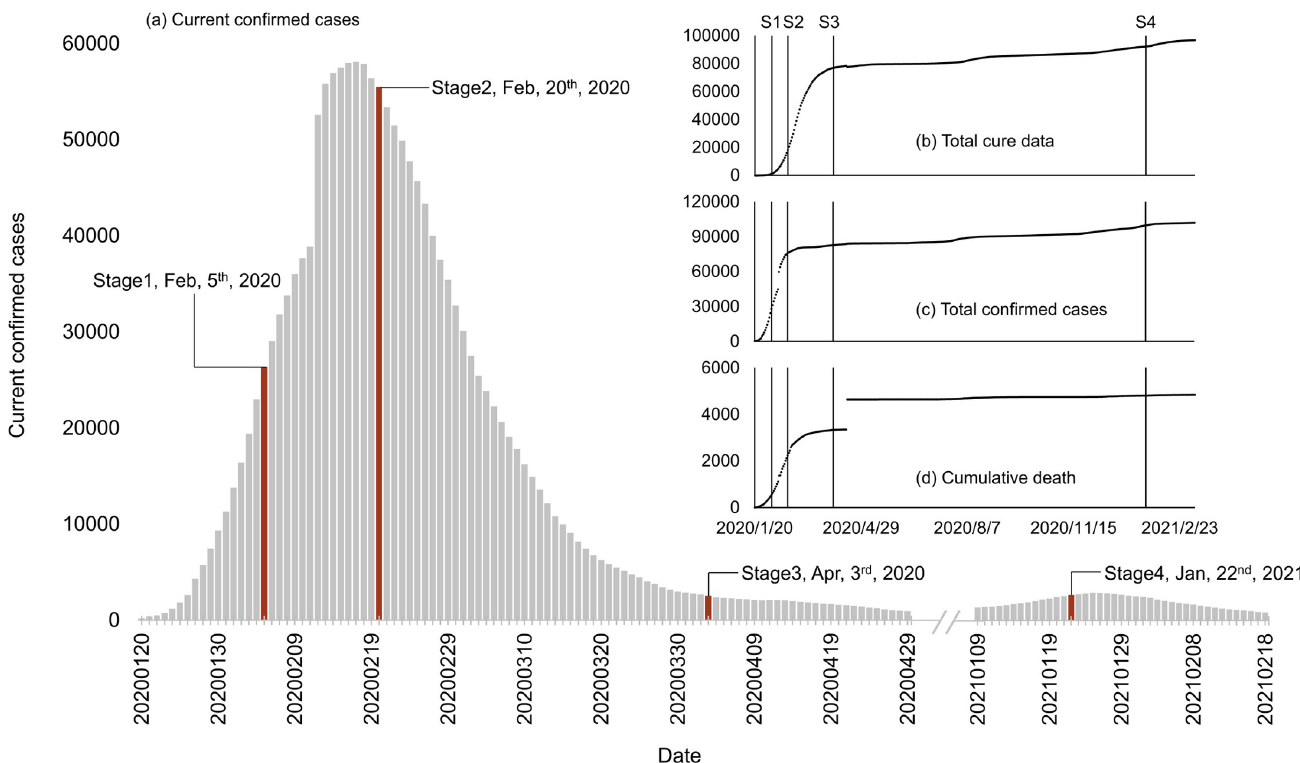
Fig 1. COVID-19 statistics in mainland China during the study period (a) Current confirmed cases, (b) total cure data, total confirmed cases and (d) cumulative deaths. Data source: http://www.nhc.gov.cn/xcs/yqtb/list_gzbd.shtml.